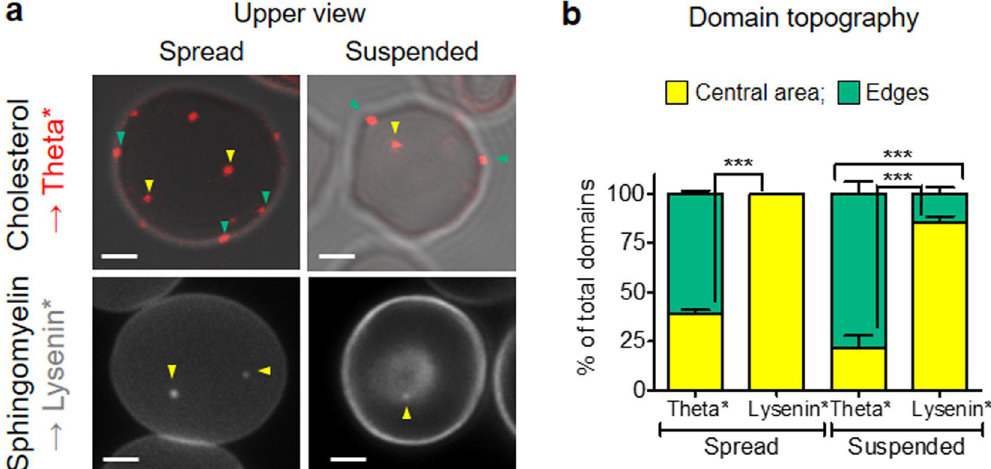
Figure 1. Distinct topographic distribution of chol- and SM-enriched domains in both spread and suspended RBCs. Fresh healthy RBCs were labelled in suspension with Theta * ( red; chol ) or Lysenin * (grey; SM) , washed and then either spread onto poly-L-lysine (PLL)-coated coverslips (spread) or left in suspension (suspended) and directly visualized by vital confocal/fluorescence microscopy. ( a ) Representative imaging. Yellow and green arrowheads point to the central area and the edges of the RBC membrane, respectively. Representative of 3 experiments, s cale bars 2 µ m. ( b ) Quantification of domain association (number by hemi-RBC expressed as percentage of total domains) with the central area ( yellow ) and the edges ( green ) of the RBC membrane. Results are means ± SEM of 40–150 RBCs from three independent experiments. Statistical significance was tested with two-sample